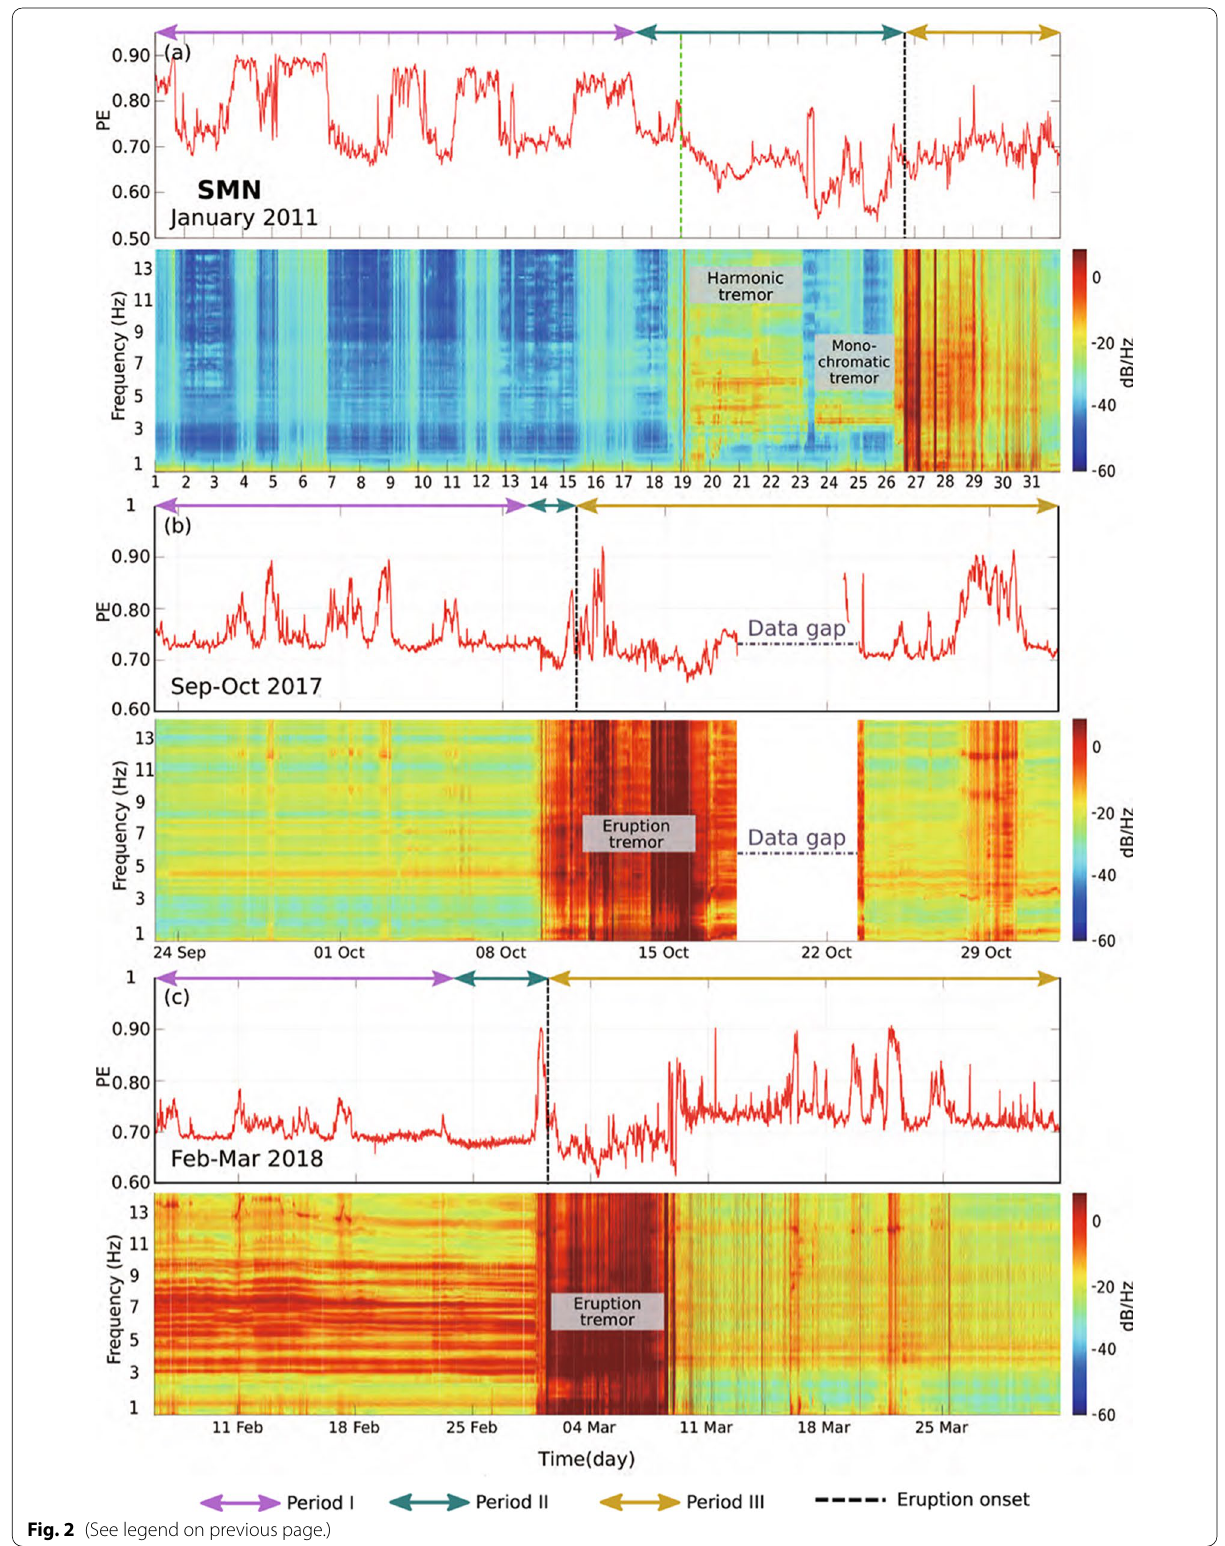
Fig. 2 (See legend on previous